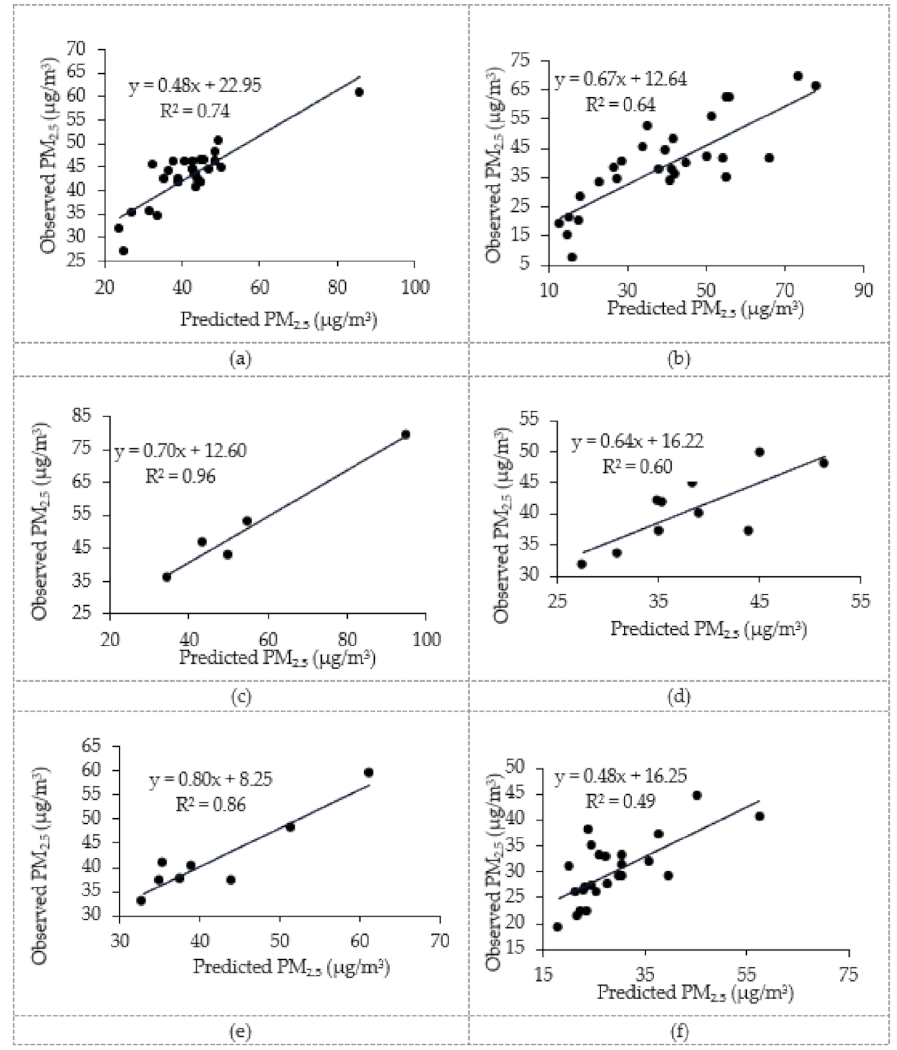
Figure 6. Comparison between observed (in situ) and estimated PM 2.5 using the linear relationship for each of the image acquisition dates. ( a – f ) Correlations between the observed and predicted PM